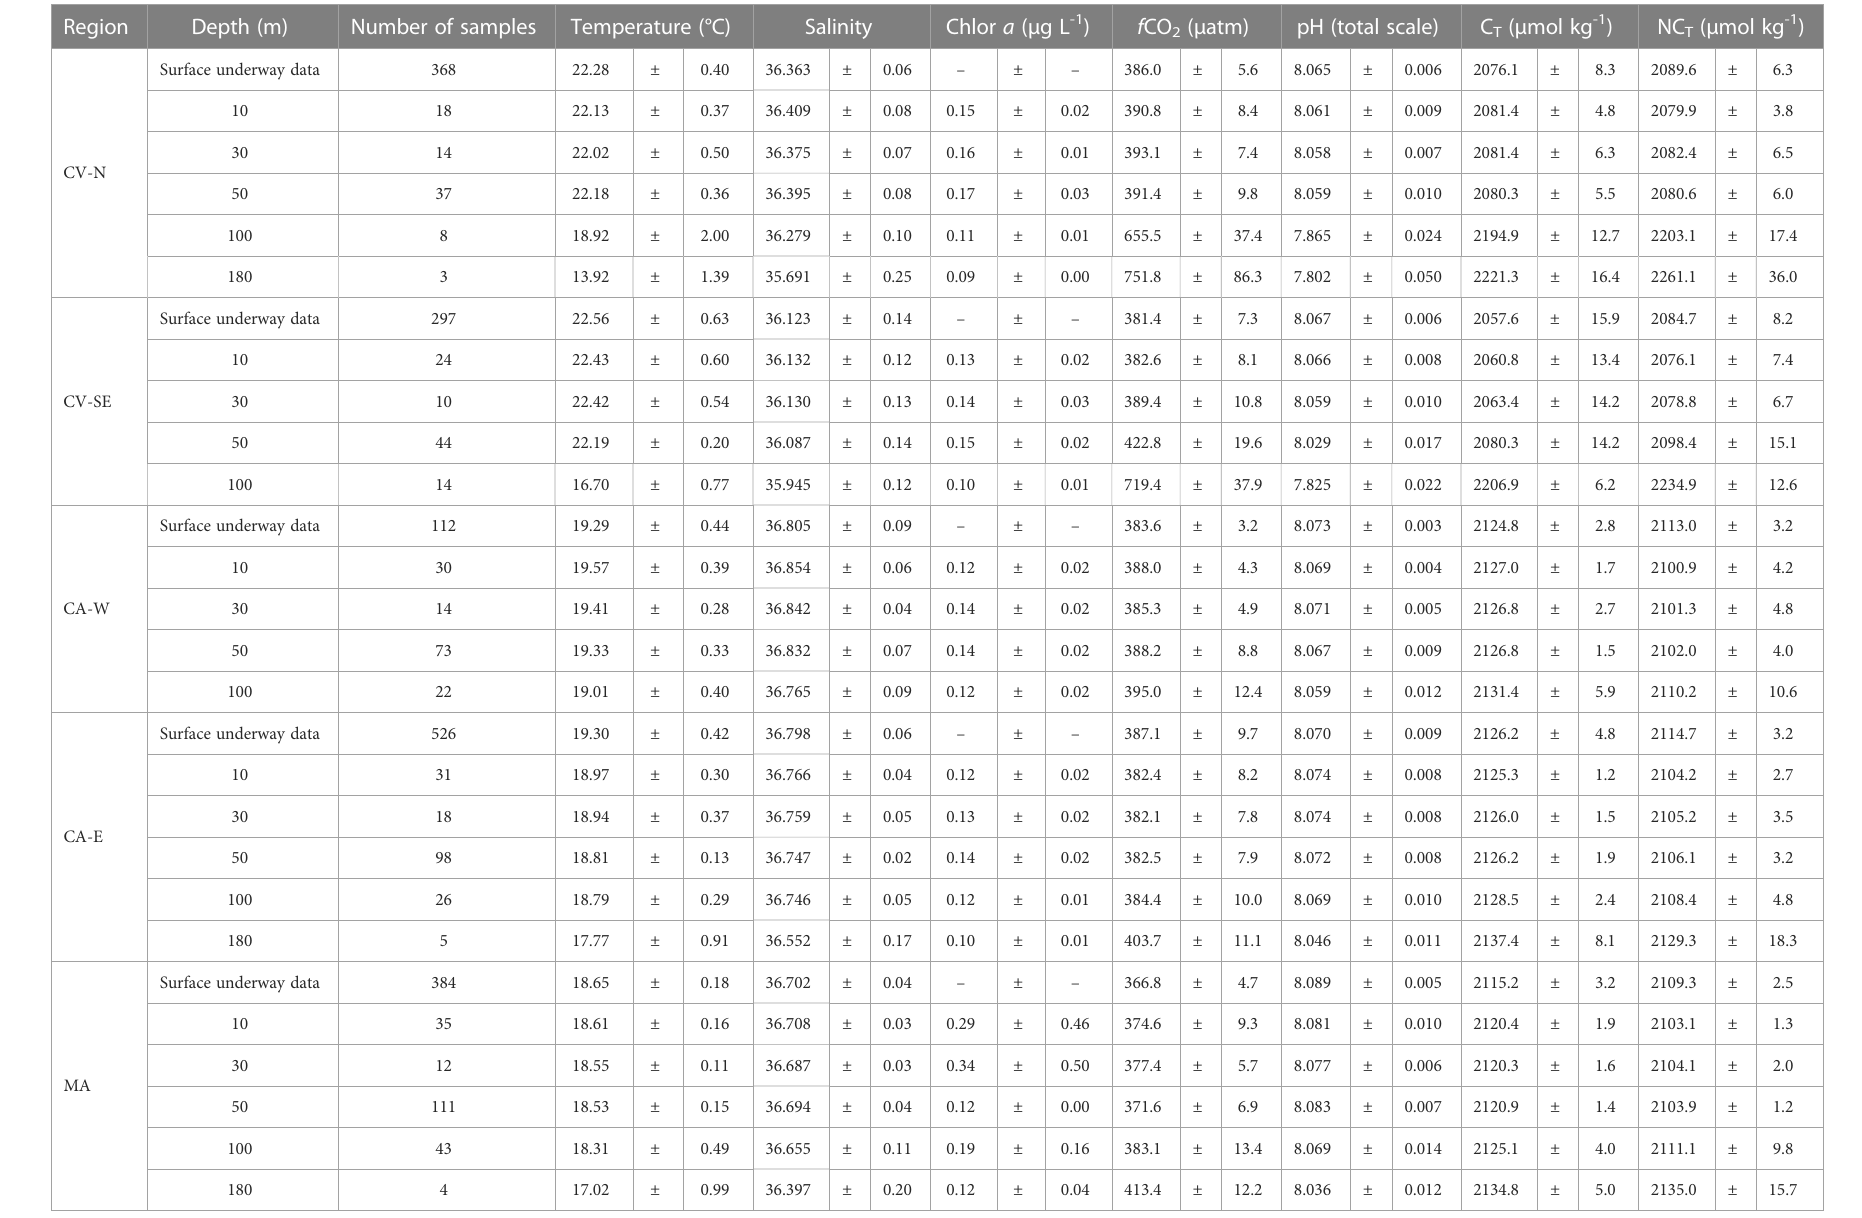
TABLE 1 Regional average of temperature, salinity, Chlorophyll a , f CO 2,sw pH, C T and NC T in the nothern and southeastern section of Cape Verde (CV-N and CV-SE, respectively), in the western and eastern section of Canary Islands (CA-W and CA-E, respectively) and in the Madeira archipelago (MA) in surface waters and at 10, 30, 50, 100 and 180 m depth. Region Depth (m) Surface underway data CV-N